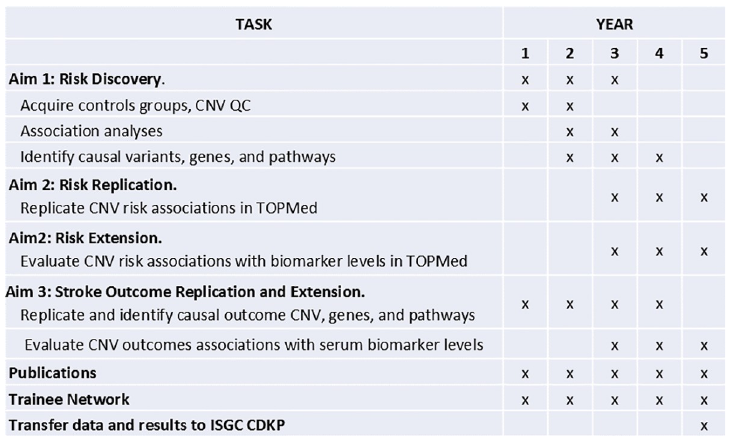
Fig 1. CaNVAS study timeline